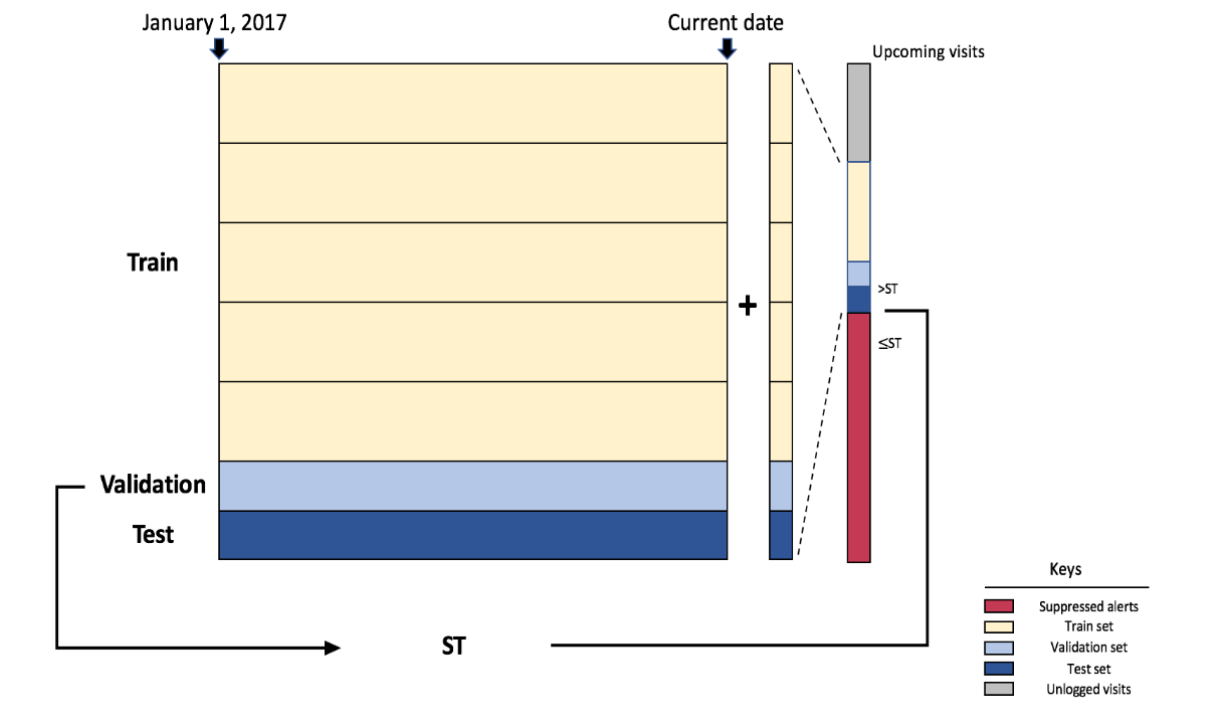
Figure 2. Experimental design. All data from January 1, 2017, to March 11, 2019, are used to train the model. Data are divided based on clinicians into 80%, 10%, 10% splits as train, validation, and test set, respectively. Each day, the data from the previous day are added to the dataset and the model is retrained and evaluated on the updated validation set to derive the 50% suppression score threshold. Predictions are made on upcoming visits (appointments) following the shingles best practice advisory (BPA) eligibility in the next day, and BPA instances are suppressed if the predicted score is lower than the threshold. Upcoming visits, which are logged into the shingles BPA log in the electronic health record system, are used for training in the future. In this design, the training window is always growing, with January 2017 as the start date. ST: score